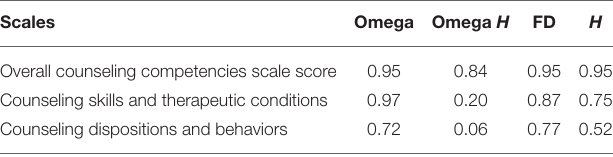
TABLE 3 | Bifactor model statistical indices for the CSS-R. Scales Omega Omega H FD H Overall counseling competencies scale score Counseling skills and therapeutic conditions Counseling dispositions and